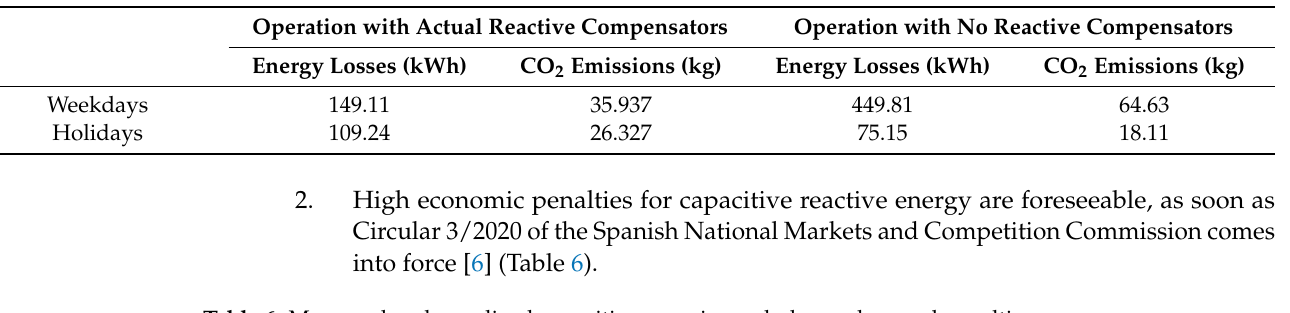
Table 6. Measured and penalized capacitive energies each day and annual penalties.